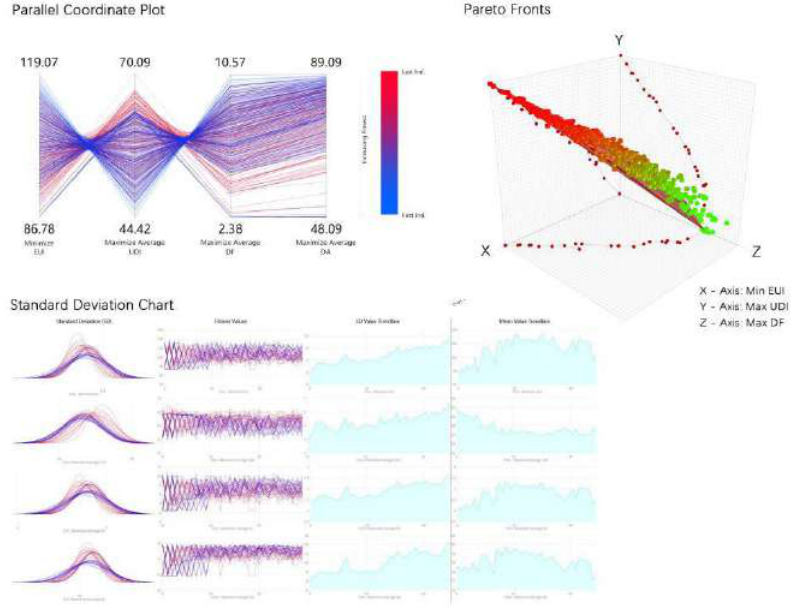
Figure 12. Parallel coordinate plot, Pareto Fronts output, standard deviation, and trendline of each